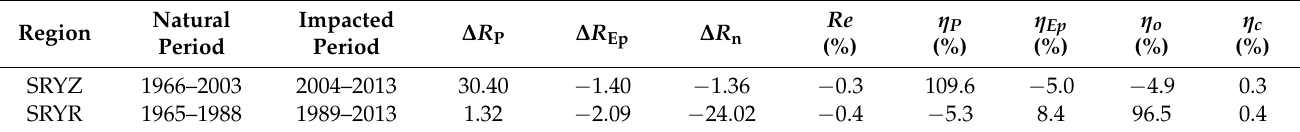
Table 4. Contribution of various impact factors to runoff variation in the SRYZ and SRYR based on the BBE